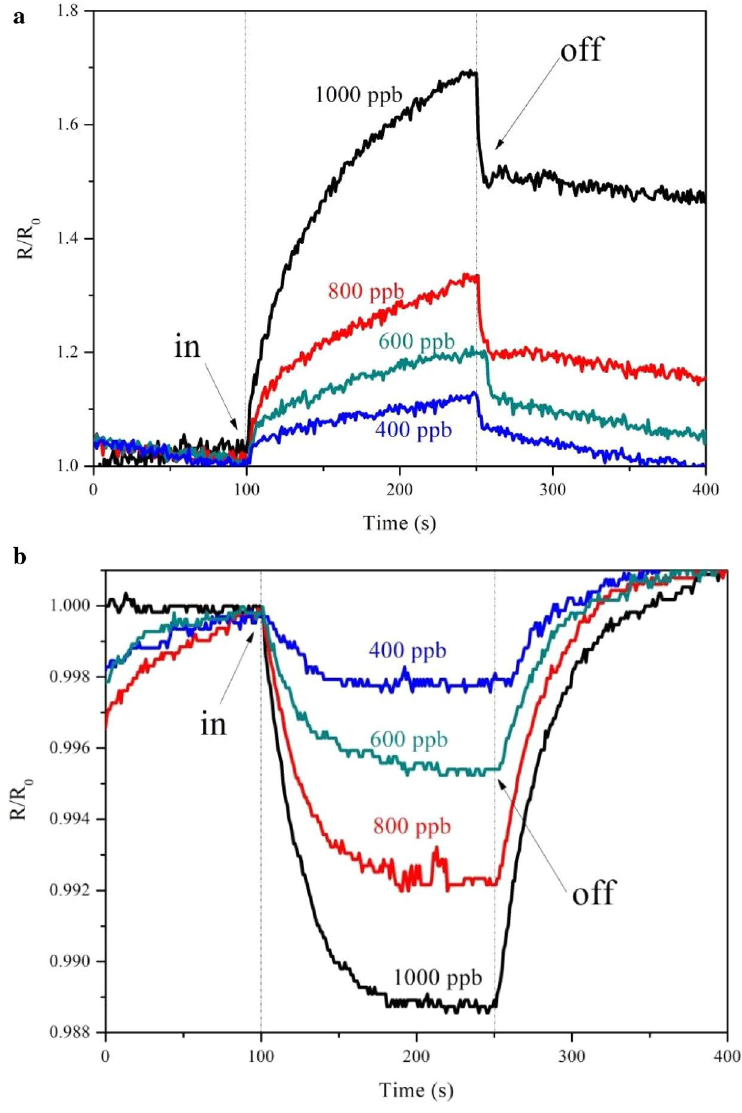
Figure 9. The relative resistance in various concentrations of 1000–400 ppb NO gas ( a ) N-rGO and ( b )